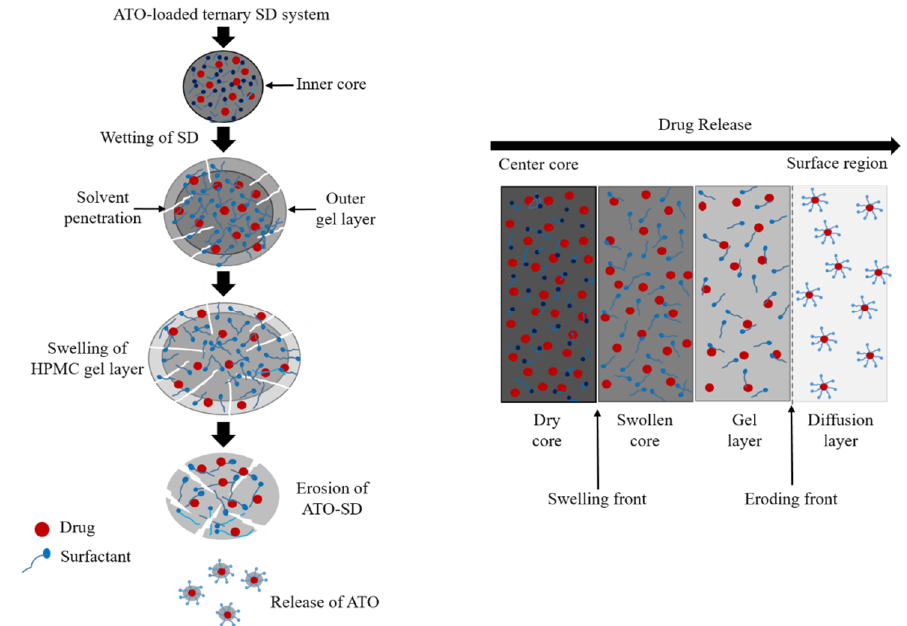
Figure 1. General schematic diagram showing drug release from a ternary solid dispersion with a hydroxypropyl methylcellulose (HPMC) carrier and a surfactant. Initial wetting hydrates the polymers and forms a gel layer around the SD. Penetration of water leads to expansion of the gel layer. Finally, as the water penetrates further into the core, the outer carrier layer becomes completely hydrated and dissolves, releasing the encapsulated drug.